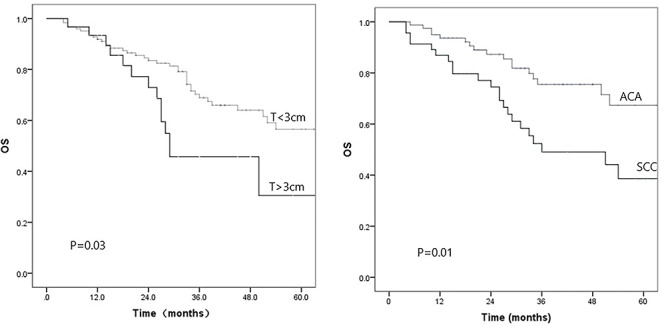
Left: survival curves stratified by tumor size (T) <3 or ≥3 cm. Right: survival curves stratified by the type of histology: adenocarcinoma (ACA) or squamous cell carcinoma (SCC).